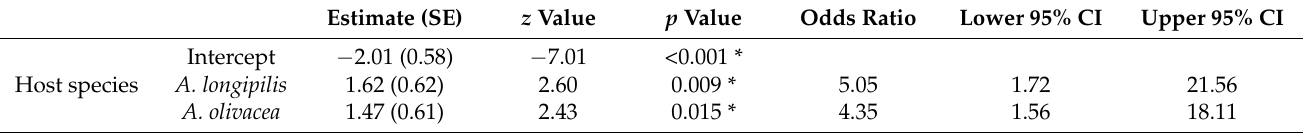
Table 5. Results of the best GLM that predicted the probability of positivity for Hymenolepis sp. in rodents. O. longicaudatus was used as the reference category. Hosmer–Lemeshow test: χ 2 = 5.16, p = 0.74 ( p > 0.05 is interpreted as fit). Estimate (SE) z Value p Value Odds Ratio